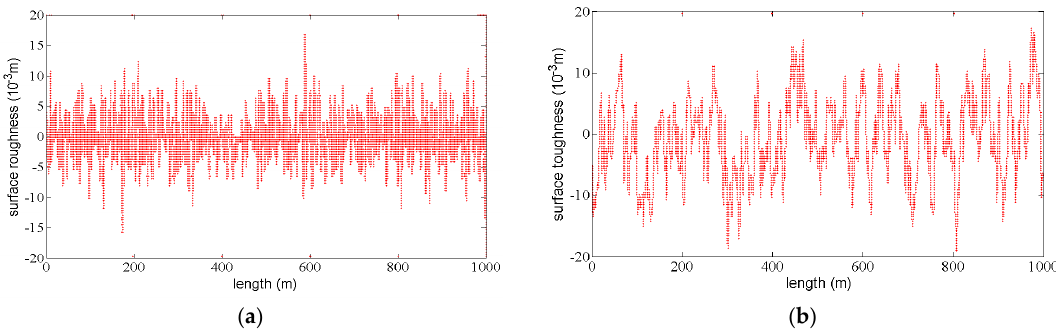
Figure 5. The surface roughness based on the national standard road roughness: ( a ) A ‐ level and ( b ) B ‐ level.